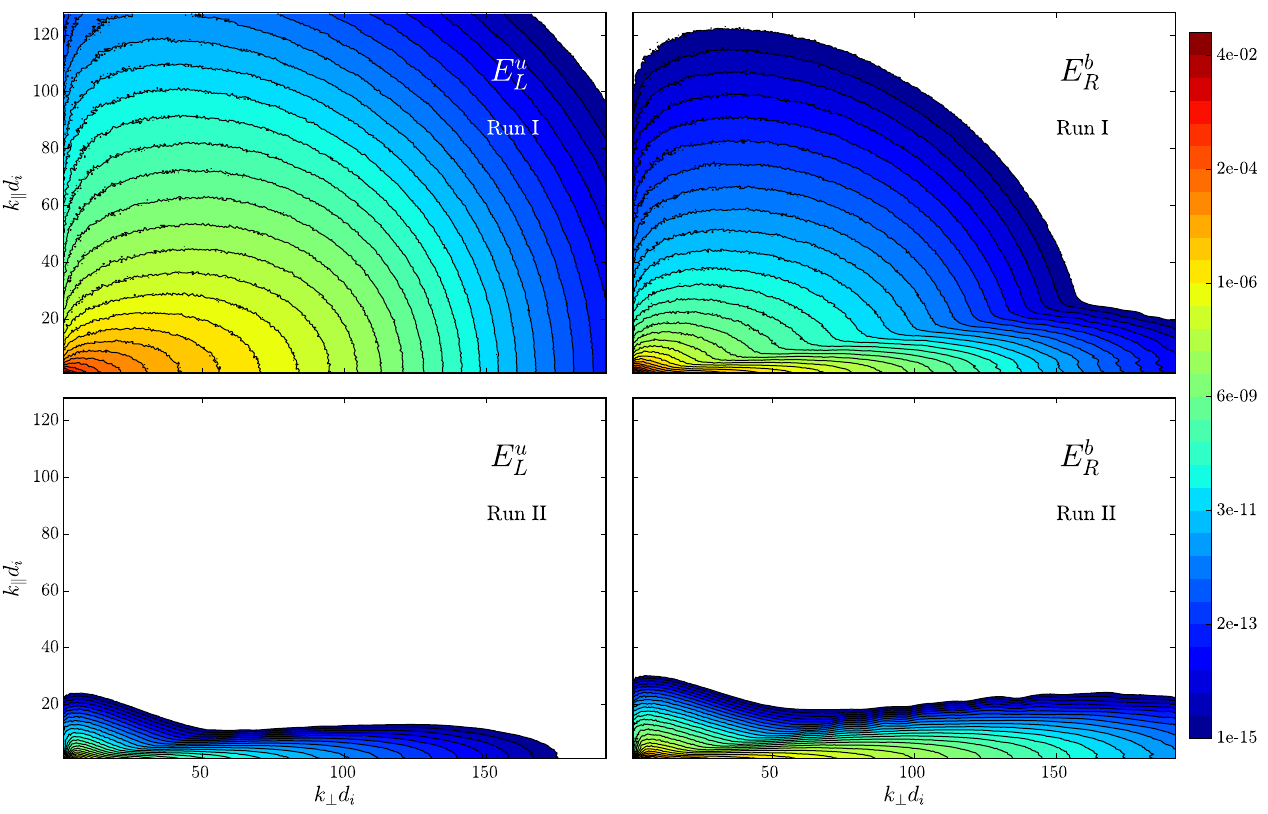
Þ (left) and R magnetic energy k